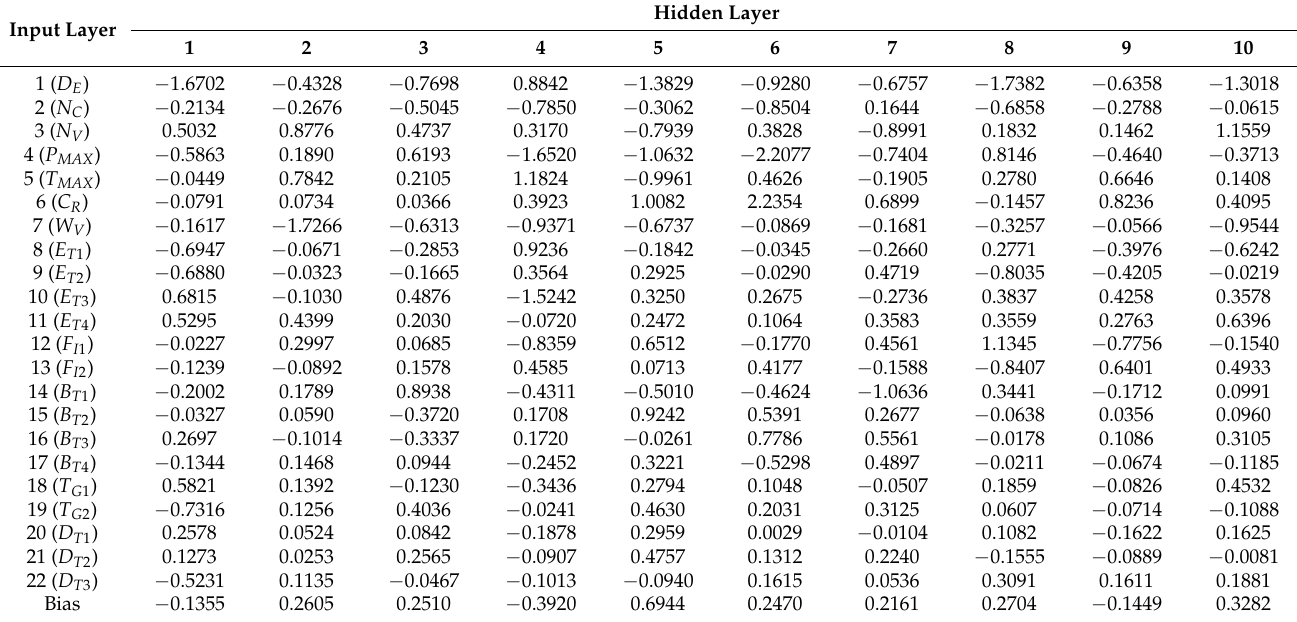
Table A1. Weights between the input layer and hidden layer in the MLP 22-10-3 artificial neural network. Input